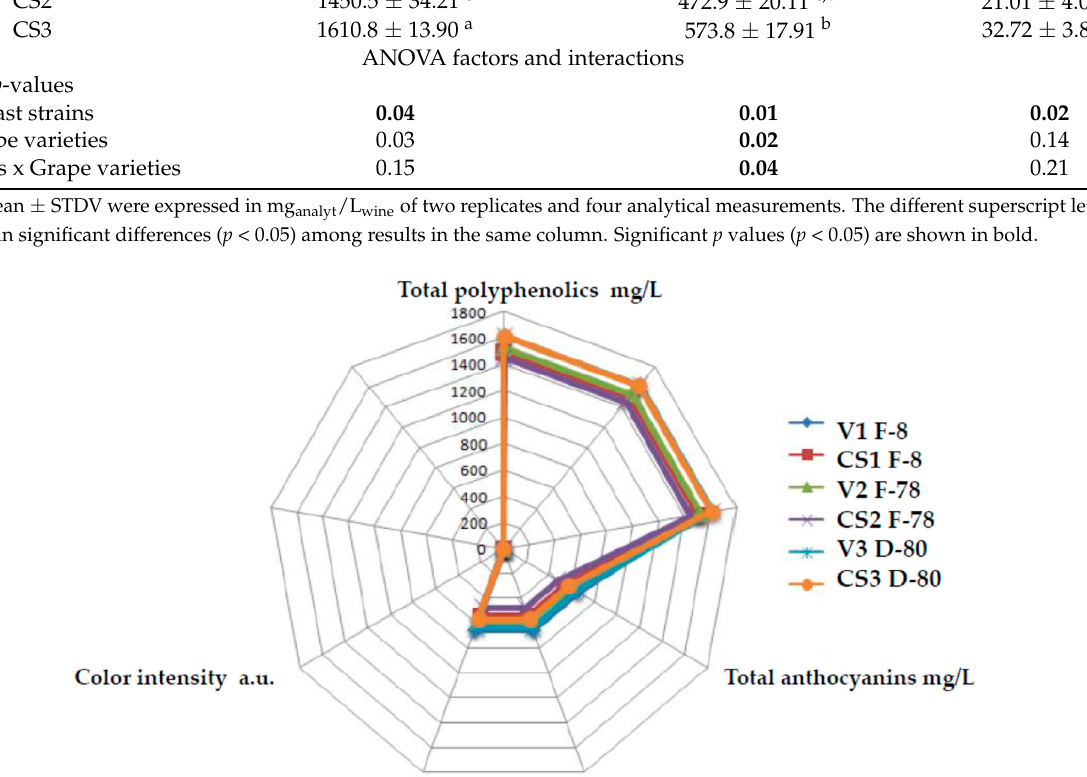
Table 5. Mean values and standard deviations (mean ± STDV) of total phenolic compounds, total anthocyanins, and color intensity (IC) of wines from the Vranec and Cabernet Sauvignon grape varieties and fermented by autochthonous and commercial yeast strains. Wine type abbreviations are defined in Table 1. Note: Mean ± STDV were expressed in mg analyt /L wine of two replicates and four analytical measurements. The different superscript letters ( a–d ) mean significant differences ( p < 0.05) among results in the same column. Significant p values ( p < 0.05) are shown in bold.